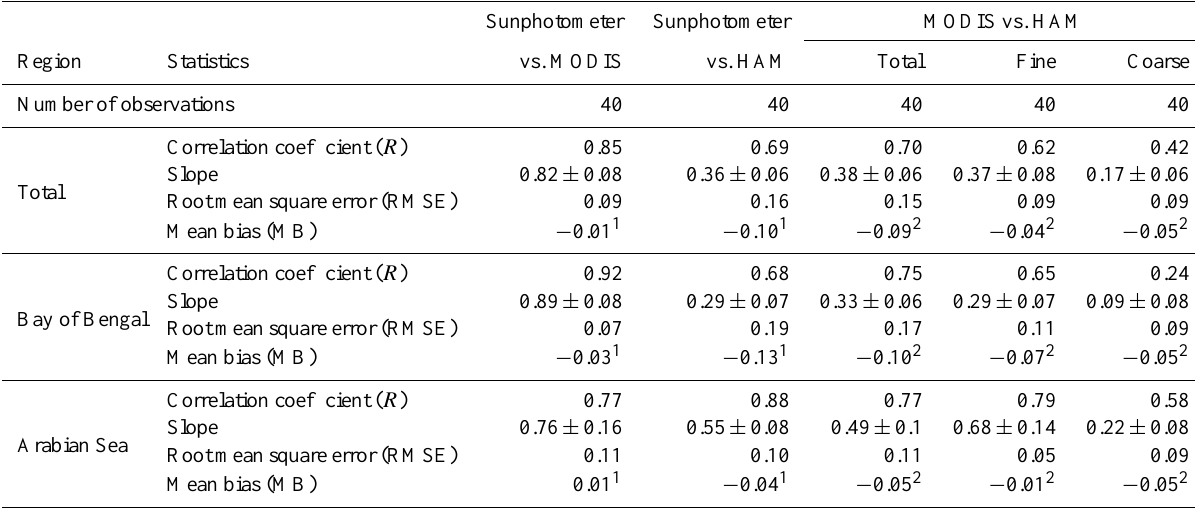
Table 2. Linear regression statistics between the ship-based remote sensing measurements, MODIS observations and model-simulated AODs over the Bay of Bengal and Arabian Sea legs during ICARB cruise period.